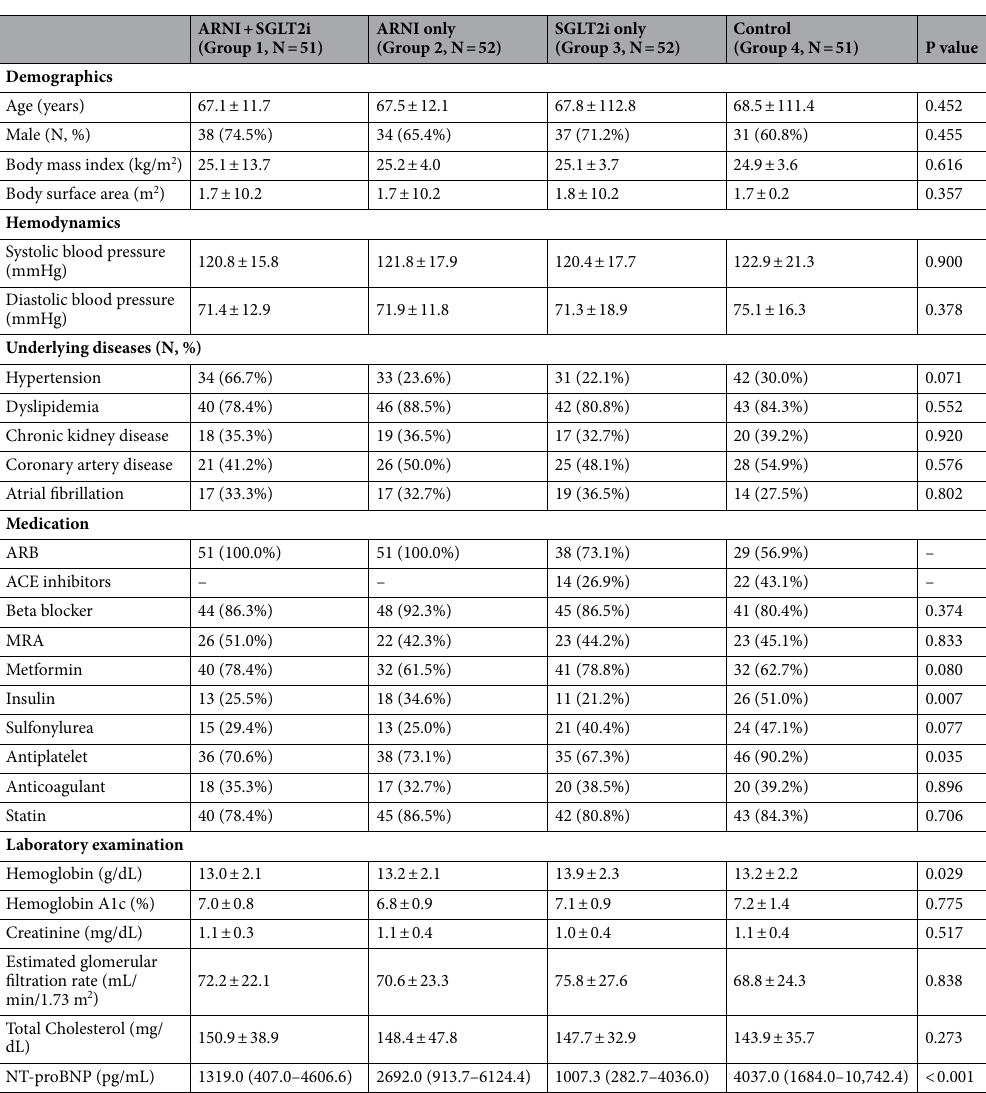
Table 1. Baseline characteristics according to the groups. ARNI angiotensin receptor-neprilysin inhibitor, SGLT2i sodium–glucose co-transporter-2 inhibitors, MRA mineralocorticoid receptor antagonist, BNP B-type natriuretic